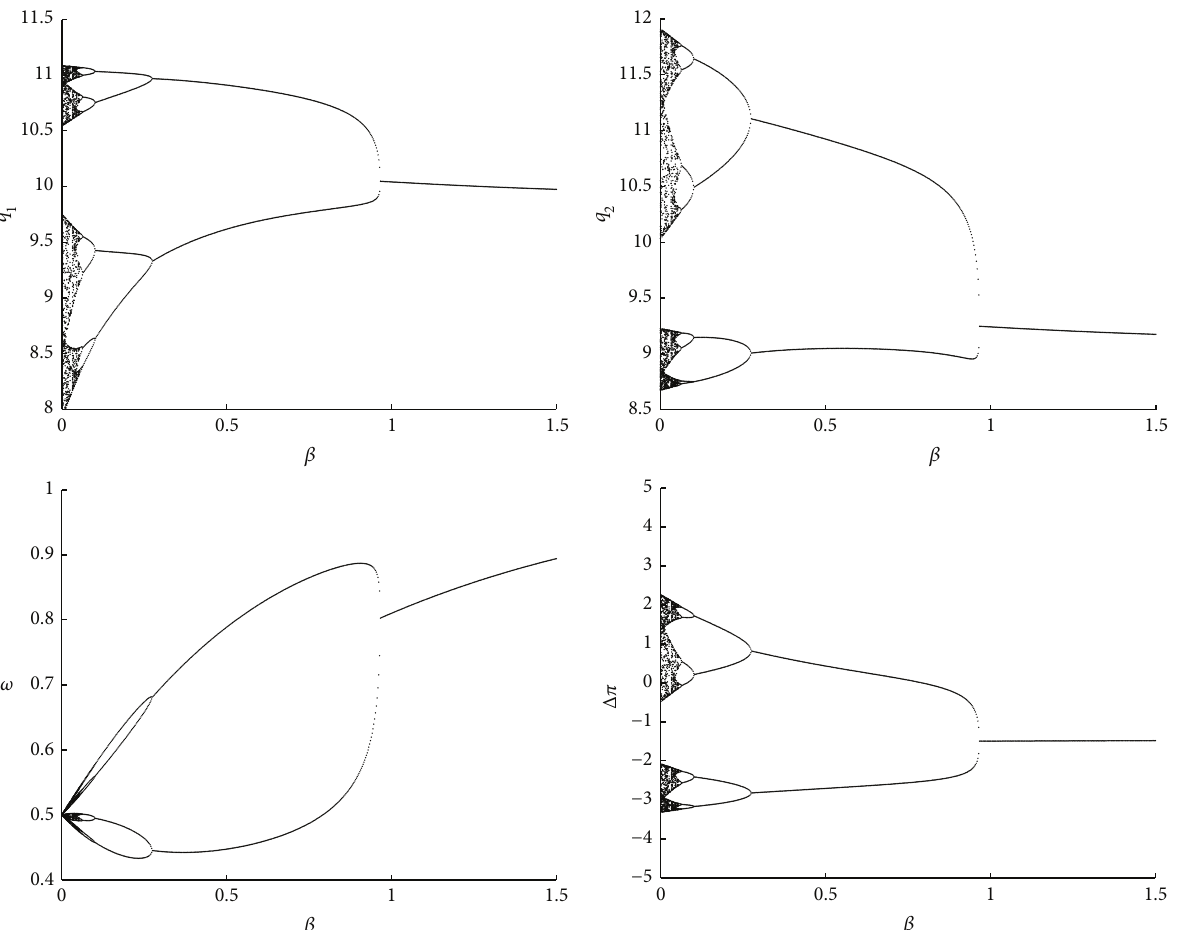
Figure 10: Bifurcation diagrams, related to the stabilizing scenario for 𝛽 , of quantities 𝑞 1 and 𝑞 2 , of fraction 𝜔 and of the net profit differential Δ𝜋 . The initial composition corresponding to 𝛽 = 0 is unstable but, since the marginal costs are sufficiently favorable to the rational firms, increasing the propensity to switch stabilizes the